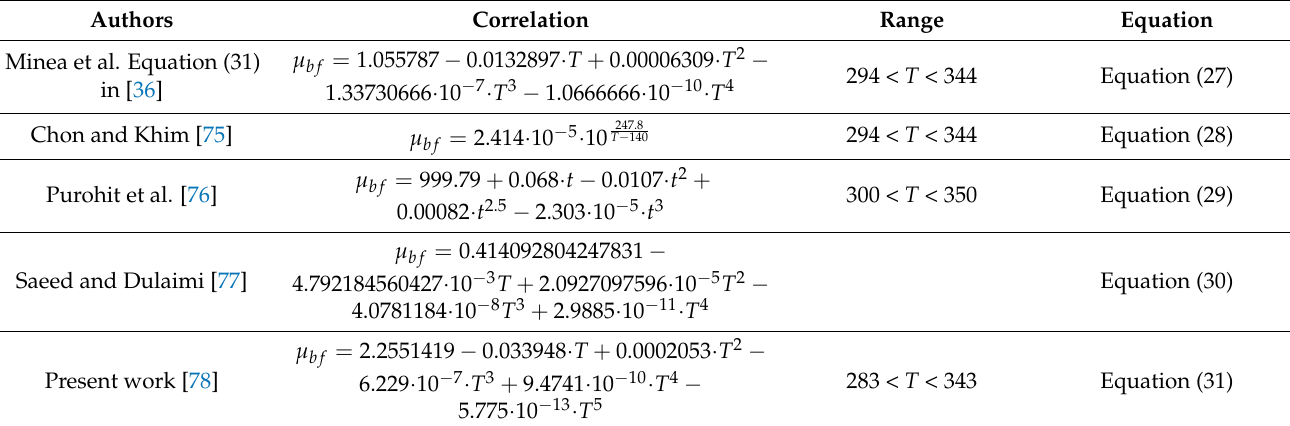
Figure 4. Viscosity of water-Al 2 O 3 nanofluids. As seen in Figure 4, viscosity of the tested nanofluids decreases sharply with a tem- perature increase and slightly increases with NPC increase. The slight influence of nano- particles on the viscosity of the tested nanofluids is due to the very small used NPC. Similarly to viscosity several correlations devoted to thermal conductivity of nanofluids are published in literature, e.g., [79,80]. In Table 6 are collected correlations proposed for water-Al 2 O 3 nanofluids.